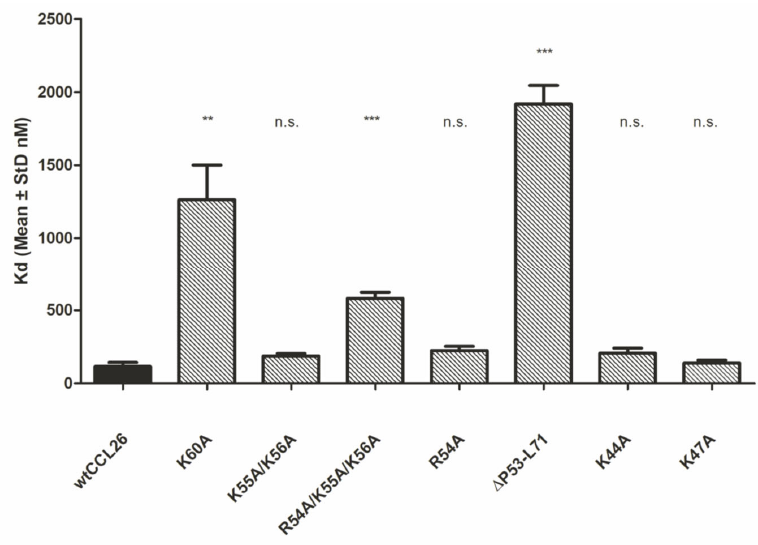
Figure 4. Kd values of CCL26 mutants ( α -helix and β -sheet mutations) to heparan sulfate in isother- mal fluorescence titration (IFT), ** p < 0.01, *** p < 0.001 was considered statistically significant (n.s.: statistically not significant).